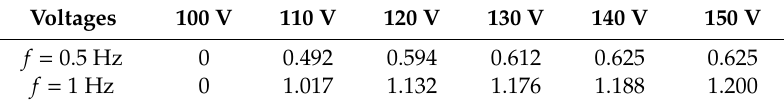
Table 2. The prototype rotational speed with different driving voltages (r/min).